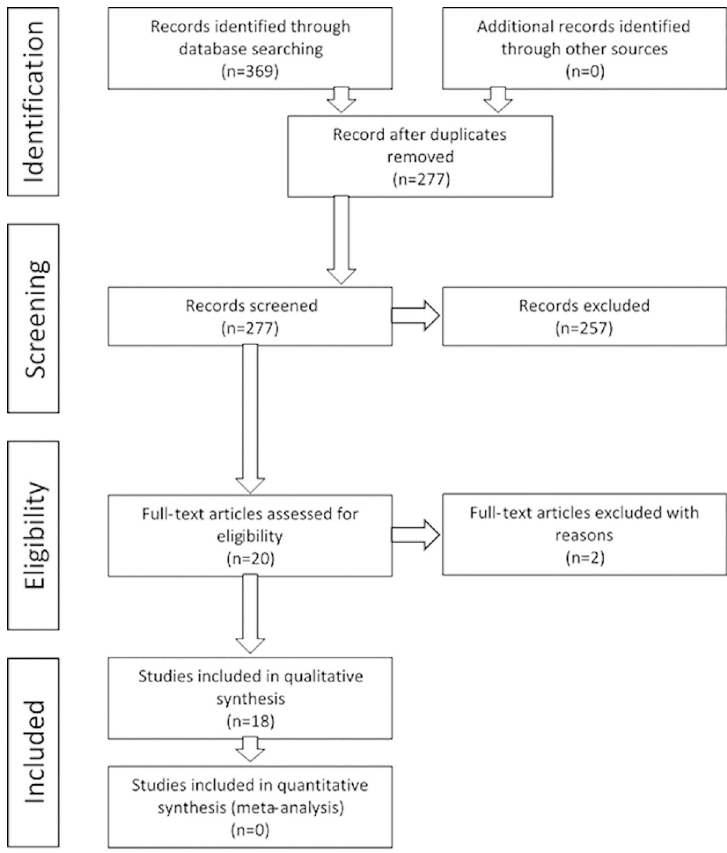
Fig 1. Preferred Reporting Items for Systematic Reviews and Meta-Analyses (PRISMA) flow